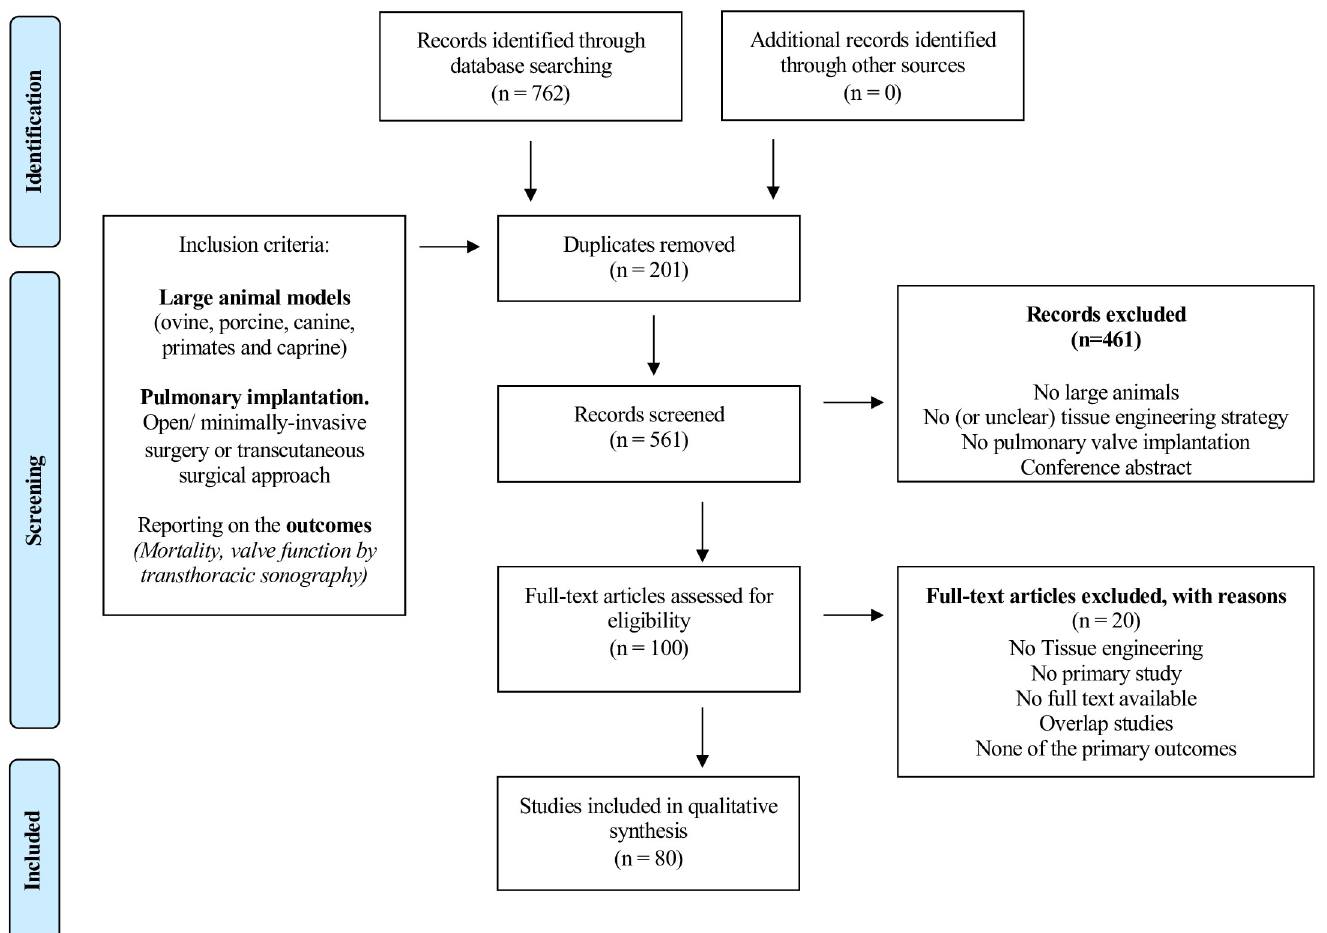
Fig 1. Flowchart outlining the protocol adapted from PRISMA